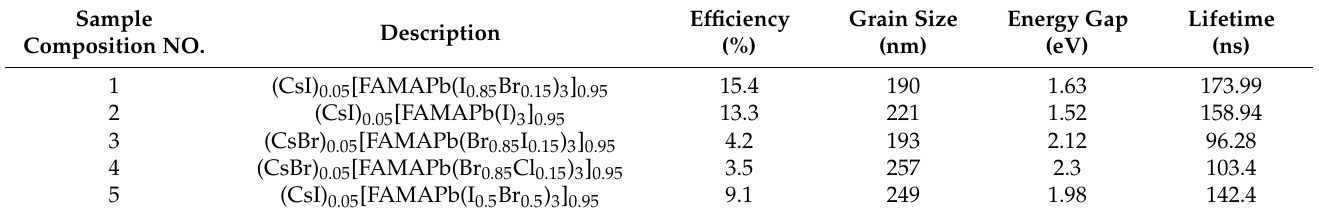
Table 2. Efficiencies, grains sizes, lifetimes and bandgaps of perovskite active layers with different